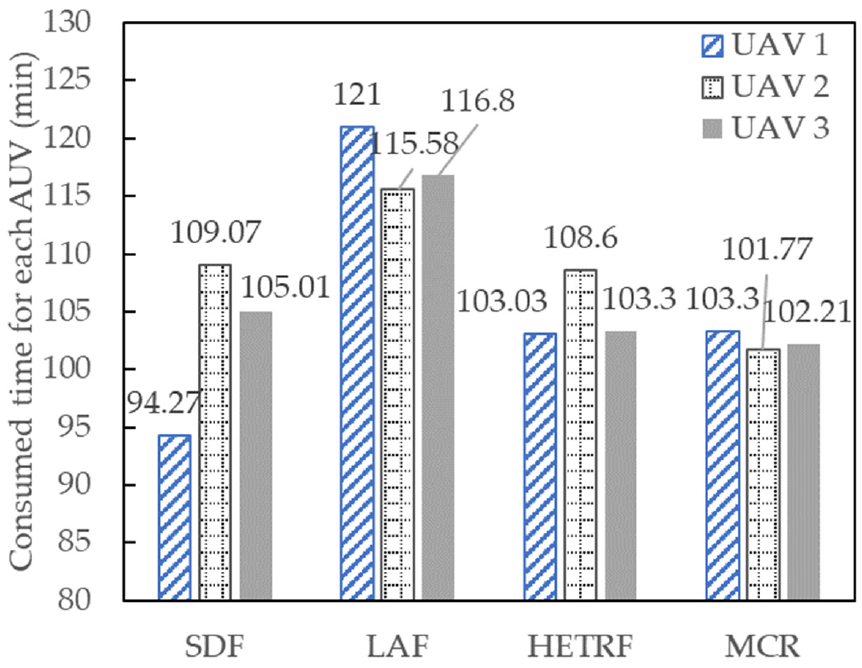
Figure 7. The consumed time of homogeneous UAVs for four algorithms.